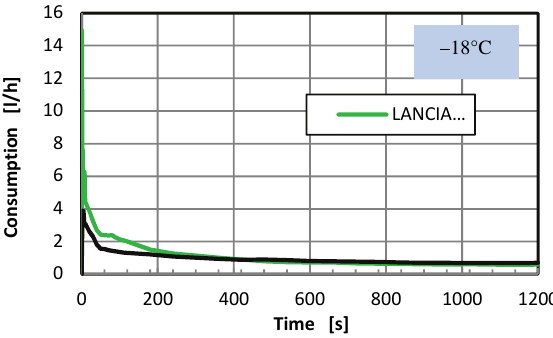
Fig. 3. Instantaneous fuel consumption at the temperature of –18°C